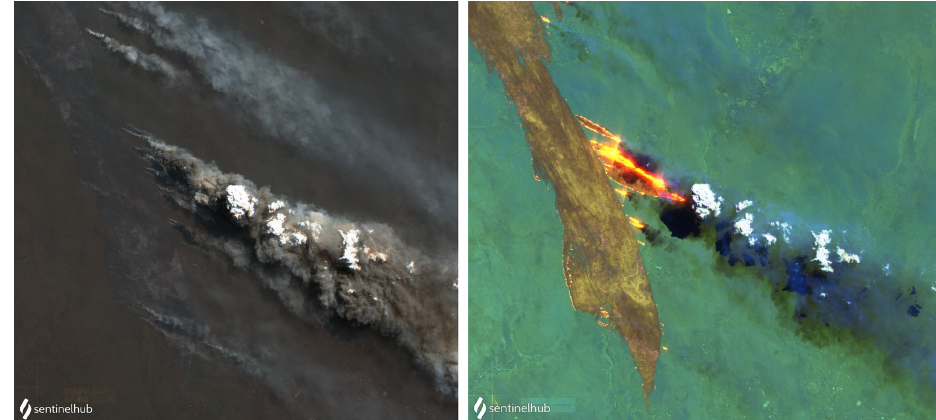
Figure 11. Sentinel-2, natural colour and atmospheric penetration, from right to left from Sentinel-2 on 18 August. Roboré, Bolivia.